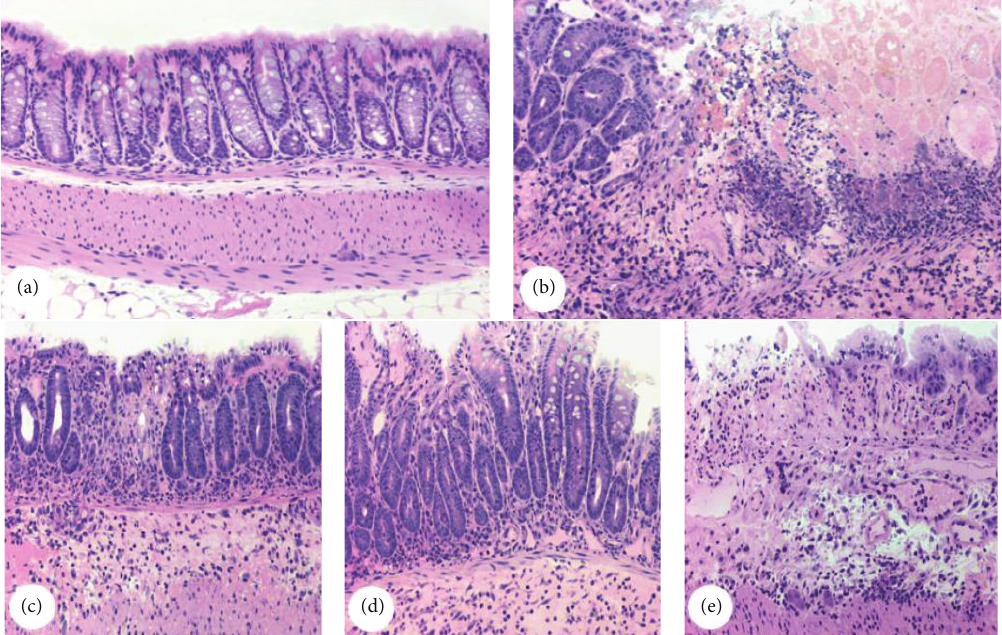
Figure 2: Representative light microscopy of colons from both colitic and noncolitic groups. Micrographs of the groups saline (a), TNBS (b), andRJ100,RJ150,andRJ200receivingbothTNBSandroyaljelly(c),(d),and(e),respectively.HematoxylinandFloxinstaining.Micrographs were taken using 10x objective lens. Each image is representative of 3 animals.